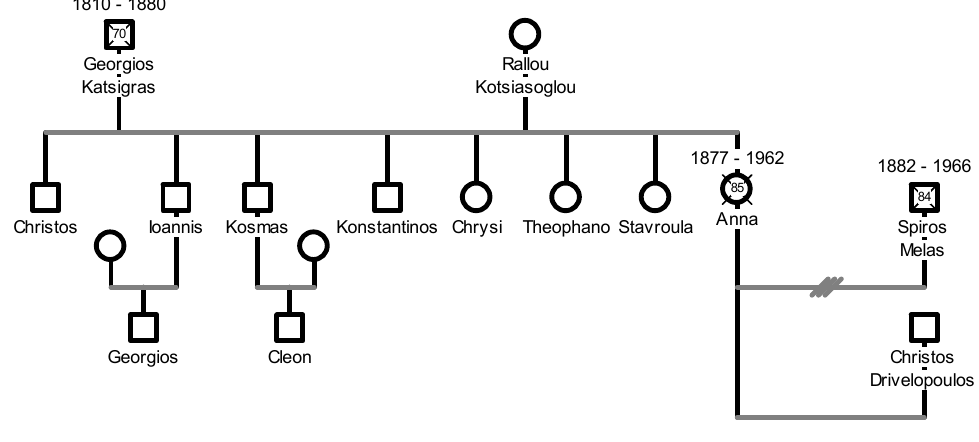
Figure 4. Anna Katsigra’s family tree.